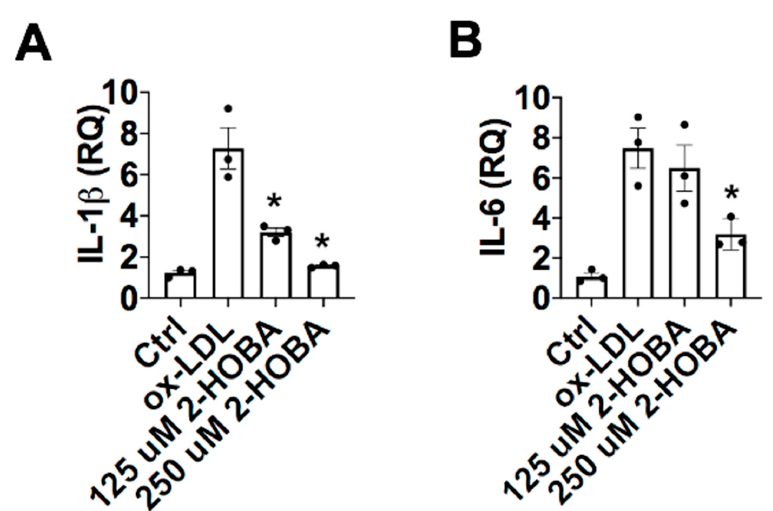
Figure 7. The mRNA levels of pro-inflammatory cytokine expression in Apoe − / − macrophages are significantly reduced by 2-HOBA. In the presence of 2-HOBA, macrophages were incubated with 50 µ g / mL oxLDL for 24 h, and then the e ff ects on macrophage expression of IL-1 β ( A ) and IL-6 ( B ) in response to oxLDL were measured. Graphs represent data (mean ± SEM) of the experiments; * p < 0.05 is indicated by comparing with ox-LDL treatment group ( A , B ) using one way ANOVA. Our studies show that FH-HDL versus control HDL contained three-fold more MDA-lysine adducts. Compared to control HDL, FH-HDL had impaired cholesterol efflux and anti-inflammatory function (Figure 6). In addition, FH patients had decreased PON1 activity compared to controls (Figure 5). The increased MDA content of FH-HDL probably contributes to its dysfunction, as direct MDA modification of control HDL impaired PON1 activity, cholesterol efflux potential, and anti-